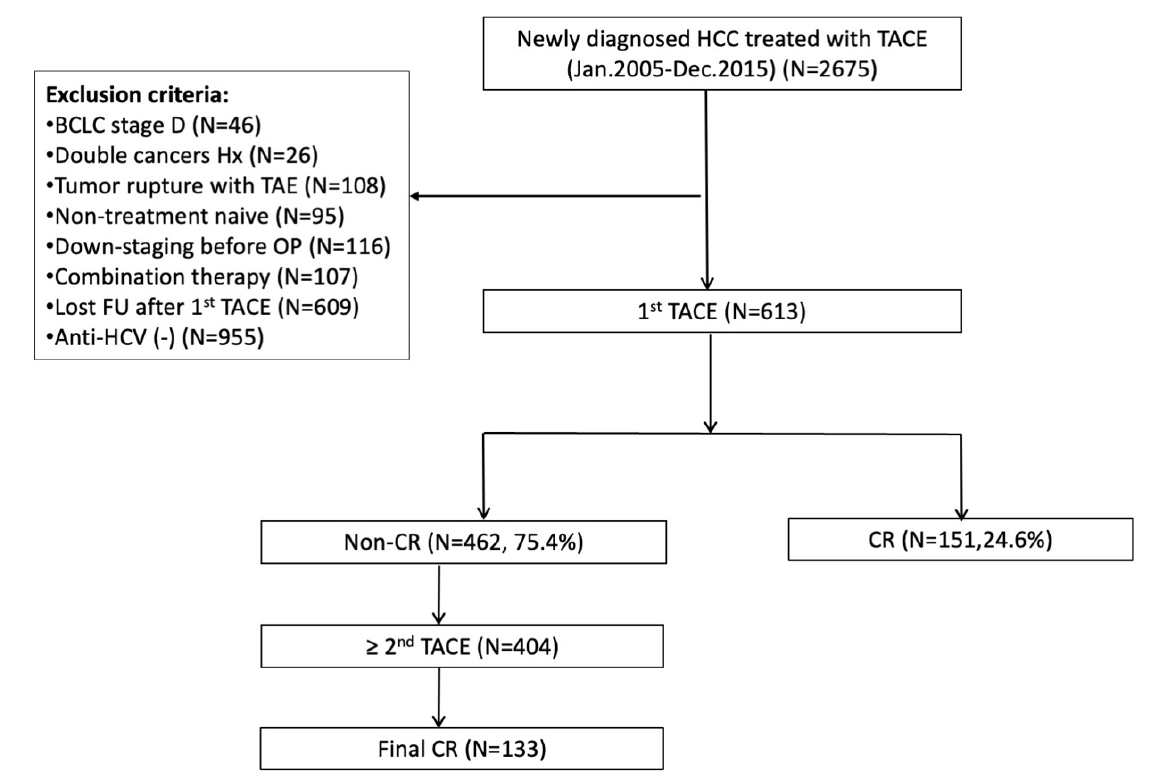
Figure 1. Flowchart of patient recruitment. BCLC, Barcelona clinic liver cancer; CR, complete response; FU, follow up; HCC, hepatocellular carcinoma; HCV, hepatitis C virus; Hx, history; OP, operation; TACE, transarterial chemoembolization; TAE, transarterial embolization.